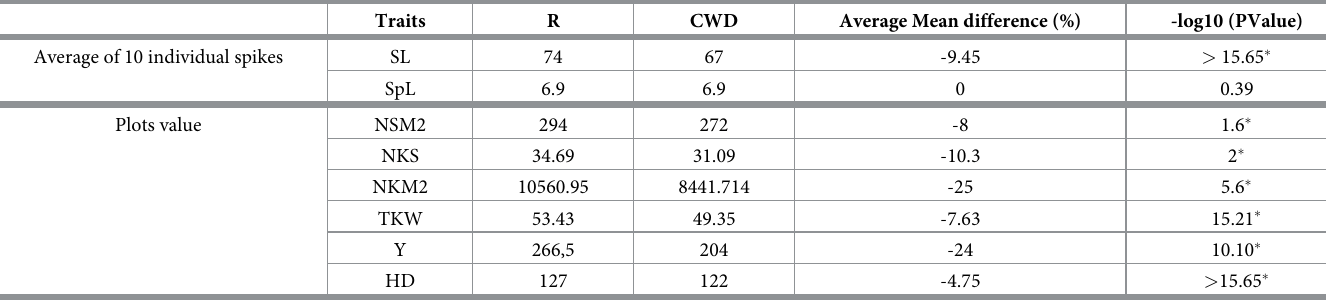
Table 1. Average values in durum wheat mixtures between two water regimes for 8 traits. Traits R CWD Average Mean difference (%) -log10 (PValue) Average of 10 individual